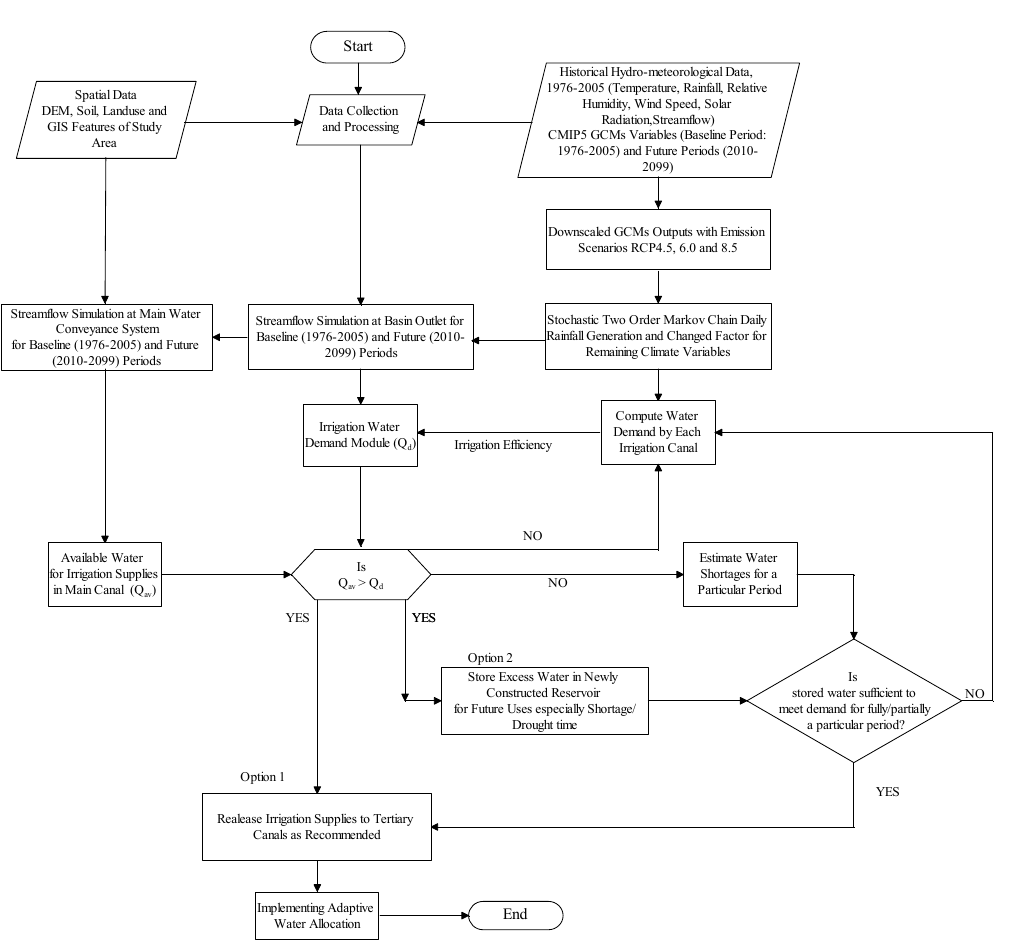
Figure 2. Framework for the development of the climate-smart agro-hydrological model.